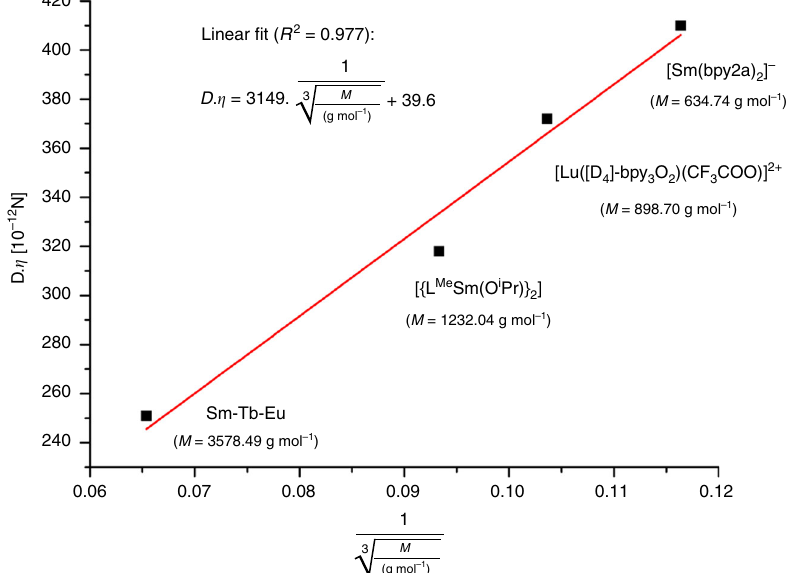
Fig. 7 Nanocode Identity. Establishing the size of Sm-Tb-Eu by 1 H DOSY NMR in CD 3 OD — linear fi t of the product of the experimentally determined diffusion coef fi cients D and the viscosity η of the solvents versus M ‒ 1/3 of the compound Sm-Tb-Eu and of reference compounds (see Supplementary Methods, Section 1.6 and Supplementary Fig.